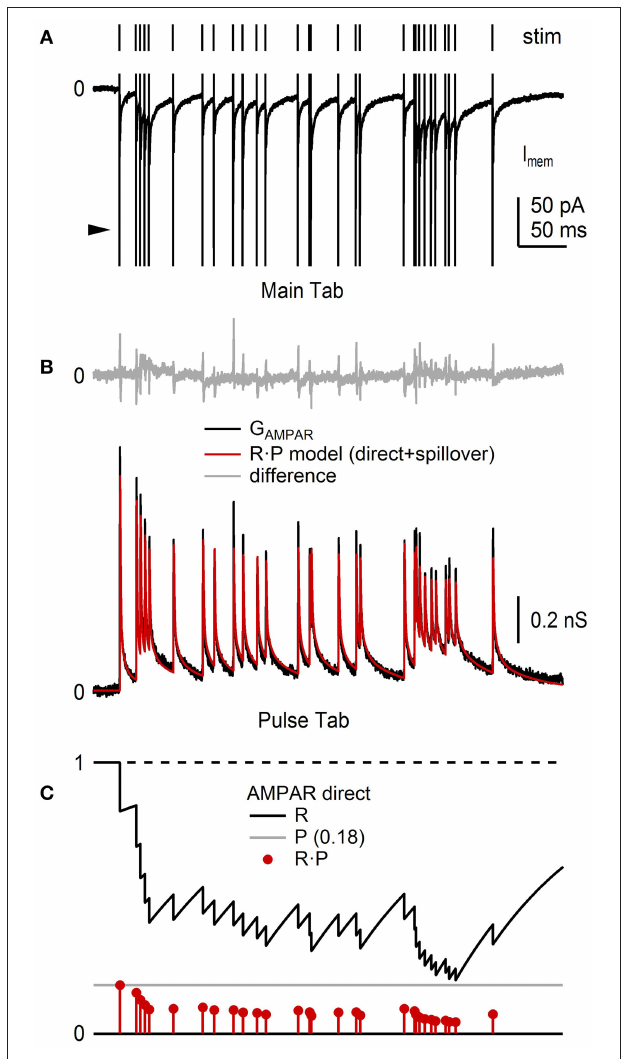
FIGURE 13 | NeuroMatic analysis and simulation of synaptic short-term plasticity. Analysis of short-term depression of EPSCs recorded from the cell body of 4 GCs. Data was recorded in voltage-clamp mode via an Axopatch 200B amplifier and Axograph software (100kHz sample rate). (A) Train of GC EPSCs containing an AMPAR and NMDAR component (bottom; control; average of 10 repetitions) evoked by stimulation of a single MF input at random Poisson intervals with mean rate of 85.6Hz (top). The large fast currents before each EPSC are stimulus artifacts (arrowhead) which have been truncated for display purposes. The NMDAR component was isolated by taking subsequent recordings in 5mM NBQX (not shown). (B) Average G AMPAR train (black) computed from EPSC trains, such as the one in (A) , from 4 GCs, as described in the main text. Red trace is an R · P plasticity model computed via the Pulse tab ( Figure 11 ) consisting of a direct and spillover component each having independent R and P dynamic variables. Top: difference between the data and model (gray). The brief transients ( < 1ms) are due to small mismatches at the peak of the direct components. Model parameters were from Billings et al. (2014), with adjustments to the amplitude and P inf values to simulate this particular G AMPAR train. (C) Plasticity model parameters R (black), P (gray) and R · P (red circles) of the direct component of the G AMPAR train in (B) , where R inf = 1, P inf = 0.14, 1 = 0, τ R = 131ms. Parameters for the spillover component (not shown) were R inf = 1, P inf = 0.68, 1 = 0, τ R = 14.85ms. GC experimental details: cerebellar slices from P40 rats, R a = 17–24 M (cid:127) , C mem = 2.4–6.0 pF, V hold = − 60 or − 66.3mV. Data is from Rothman et al.